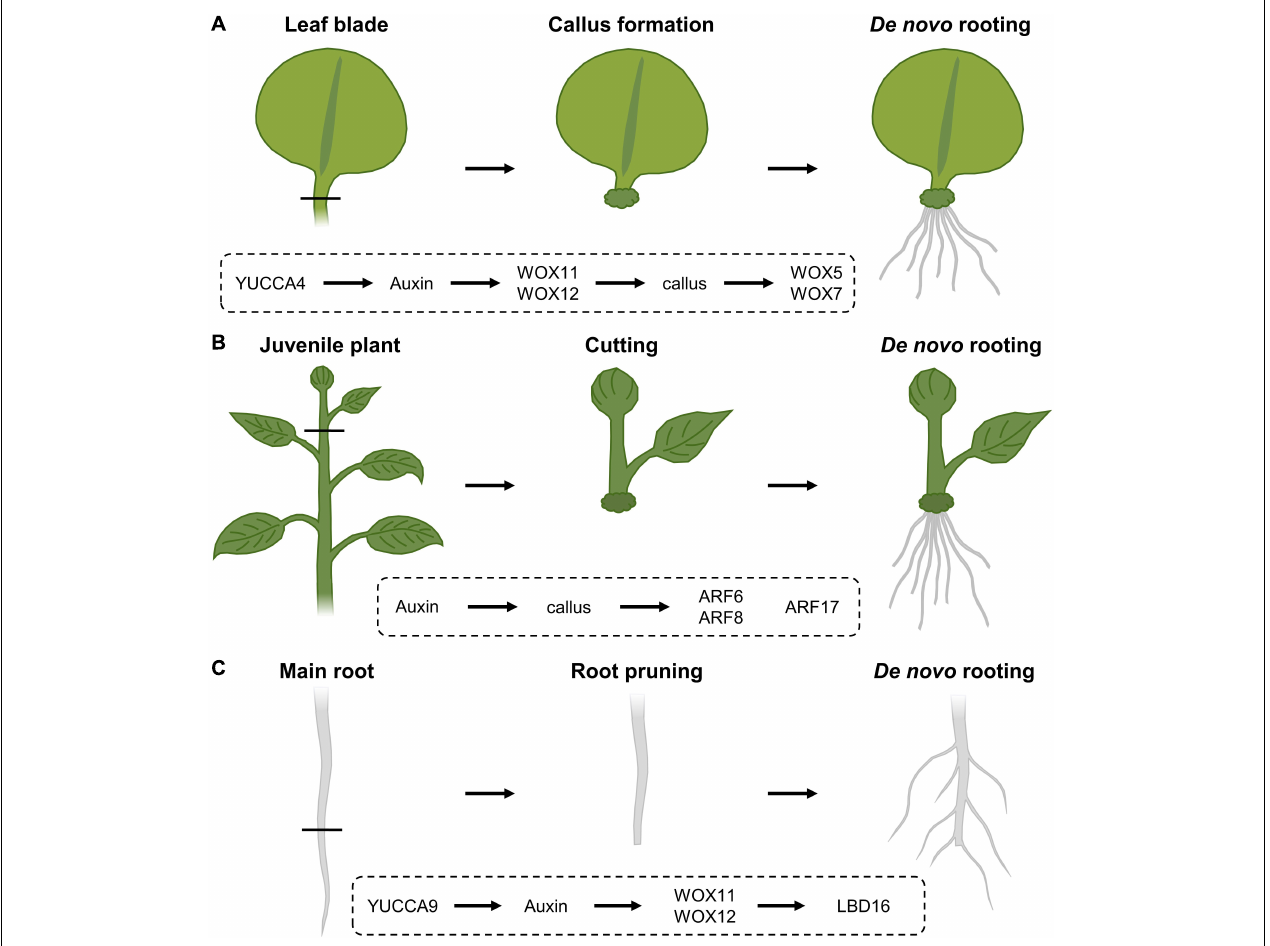
FIGURE 3 | Regeneration response following (A) leaf blade excision, (B) stem cuttings and (C) root pruning, and the corresponding molecular cascades involved. (A) Upon leaf blade excision, YUCCA4-mediated auxin biosynthesis results in the induction of WOX11 and WOX12 , resulting in callus generation from local cambial cells. Following callus induction, WOX11 and WOX12 activate the expression of WOX5 and WOX7 that will initiate root primordia. (B) In cuttings from stems, auxin triggers callus formation and the expression of ARF6 and ARF8 , being positive regulators of the rooting process, as well as ARF17 , a negative regulator of de novo rooting. (C) Following cutting of the main root system, YUCCA9-dependent auxin biosynthesis activates the expression of WOX11 and WOX12 , that in turn regulate LBD16 expression, being needed to induce